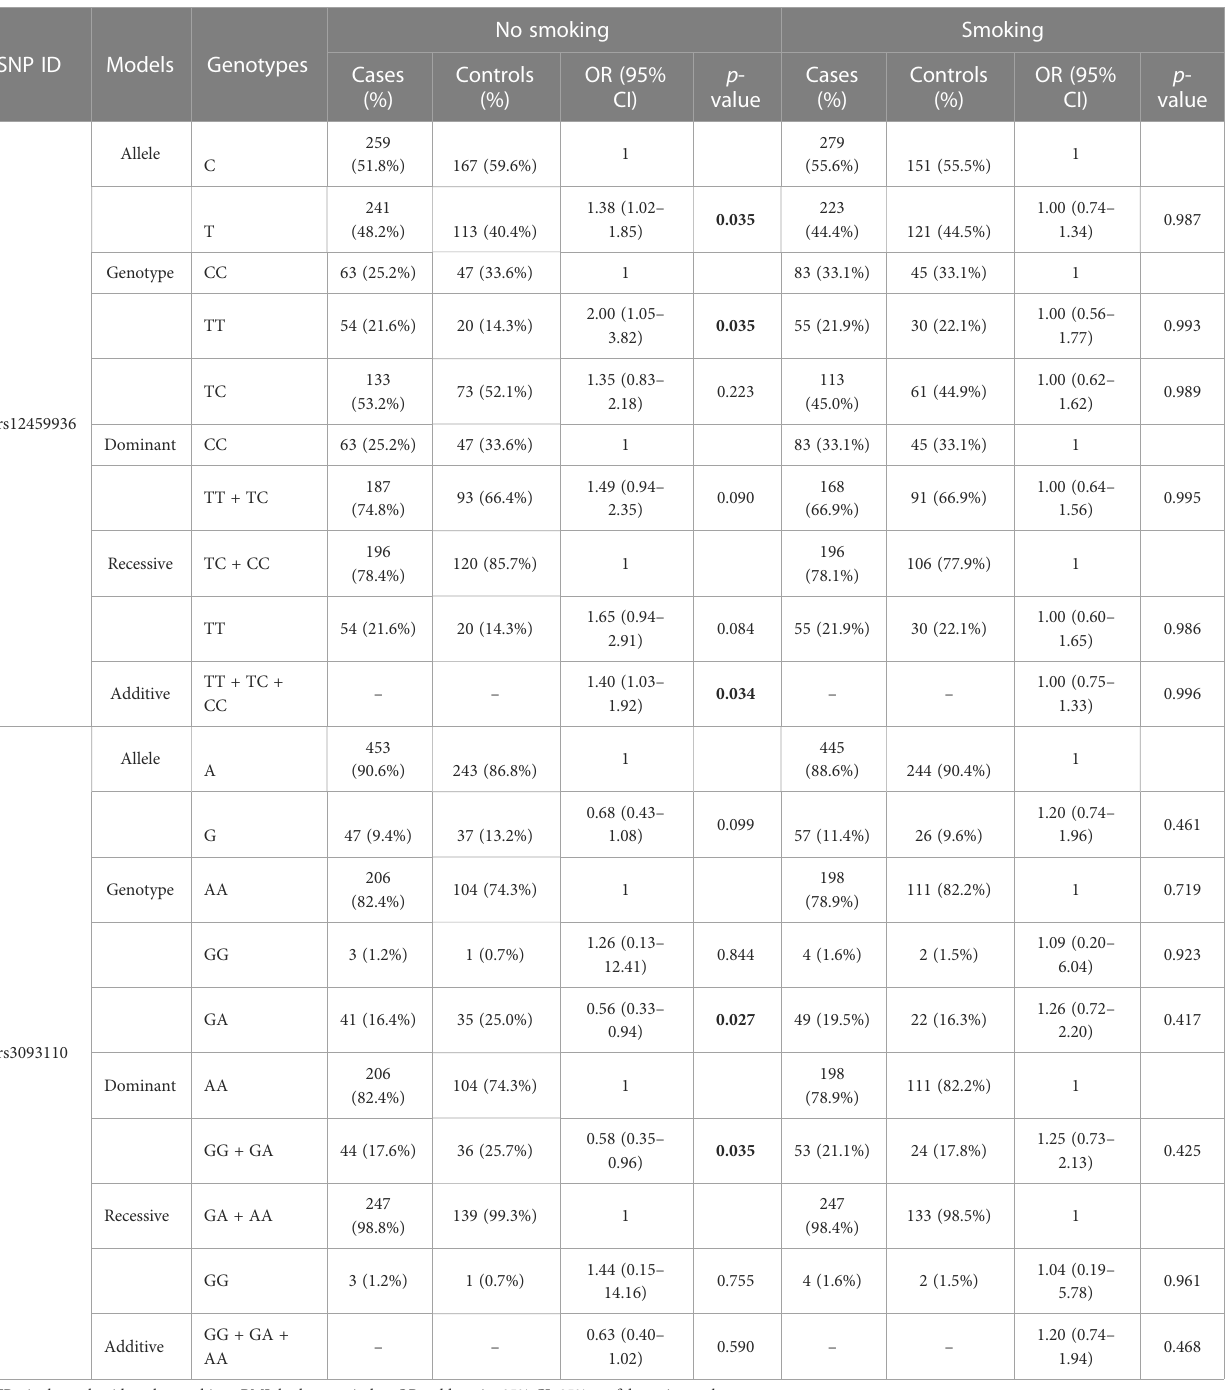
TABLE 3 The association of variants in CYP4F2 with lung cancer susceptibility strati fi ed by smoking